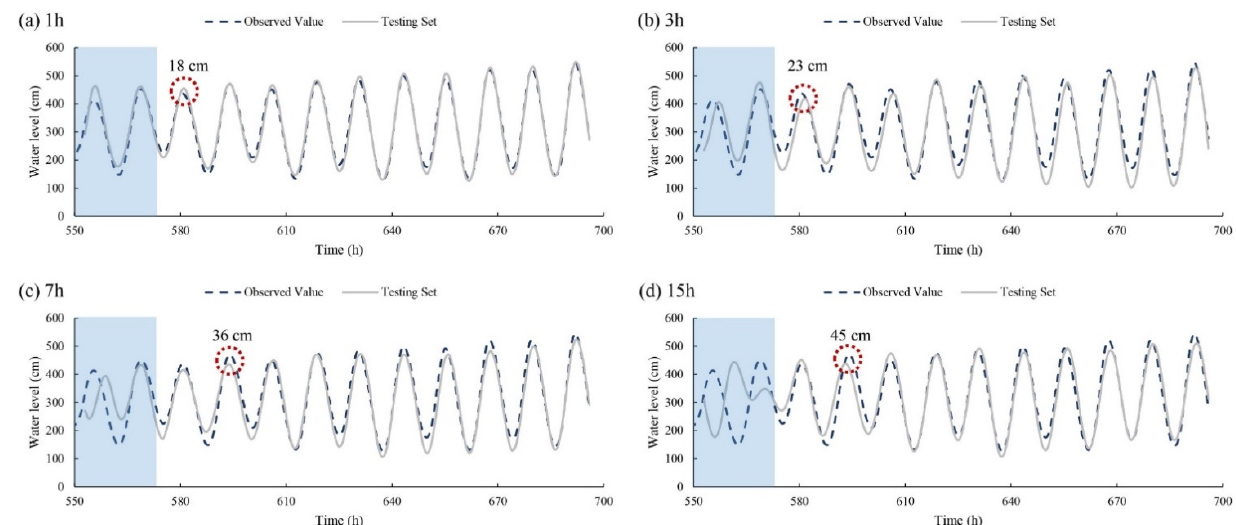
Figure 5. Model results of testing set for the LSTM model with ( a ) 1 h, ( b ) 3 h, ( c ) 7 h, and ( d ) 15 h prediction times. Red dash line circle represents the maximum difference between the modelled and observed values at the water level peak. Light blue areas are the cold start subsets for all prediction times.